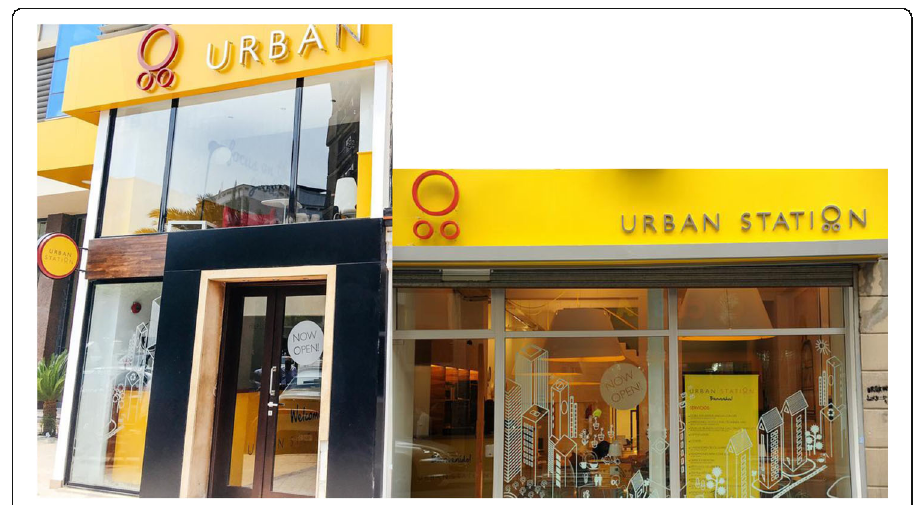
Fig. 10 Urban station pic in Egypt on the left and in Argentina on the right. Source: